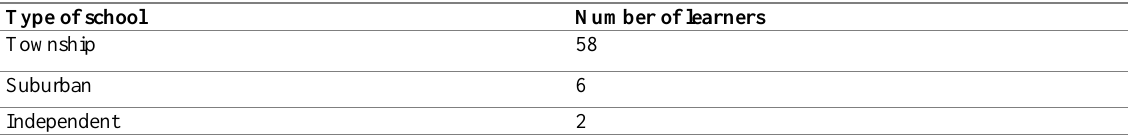
Table 2: Number of Grade 10 learners in South African township, suburban and independent